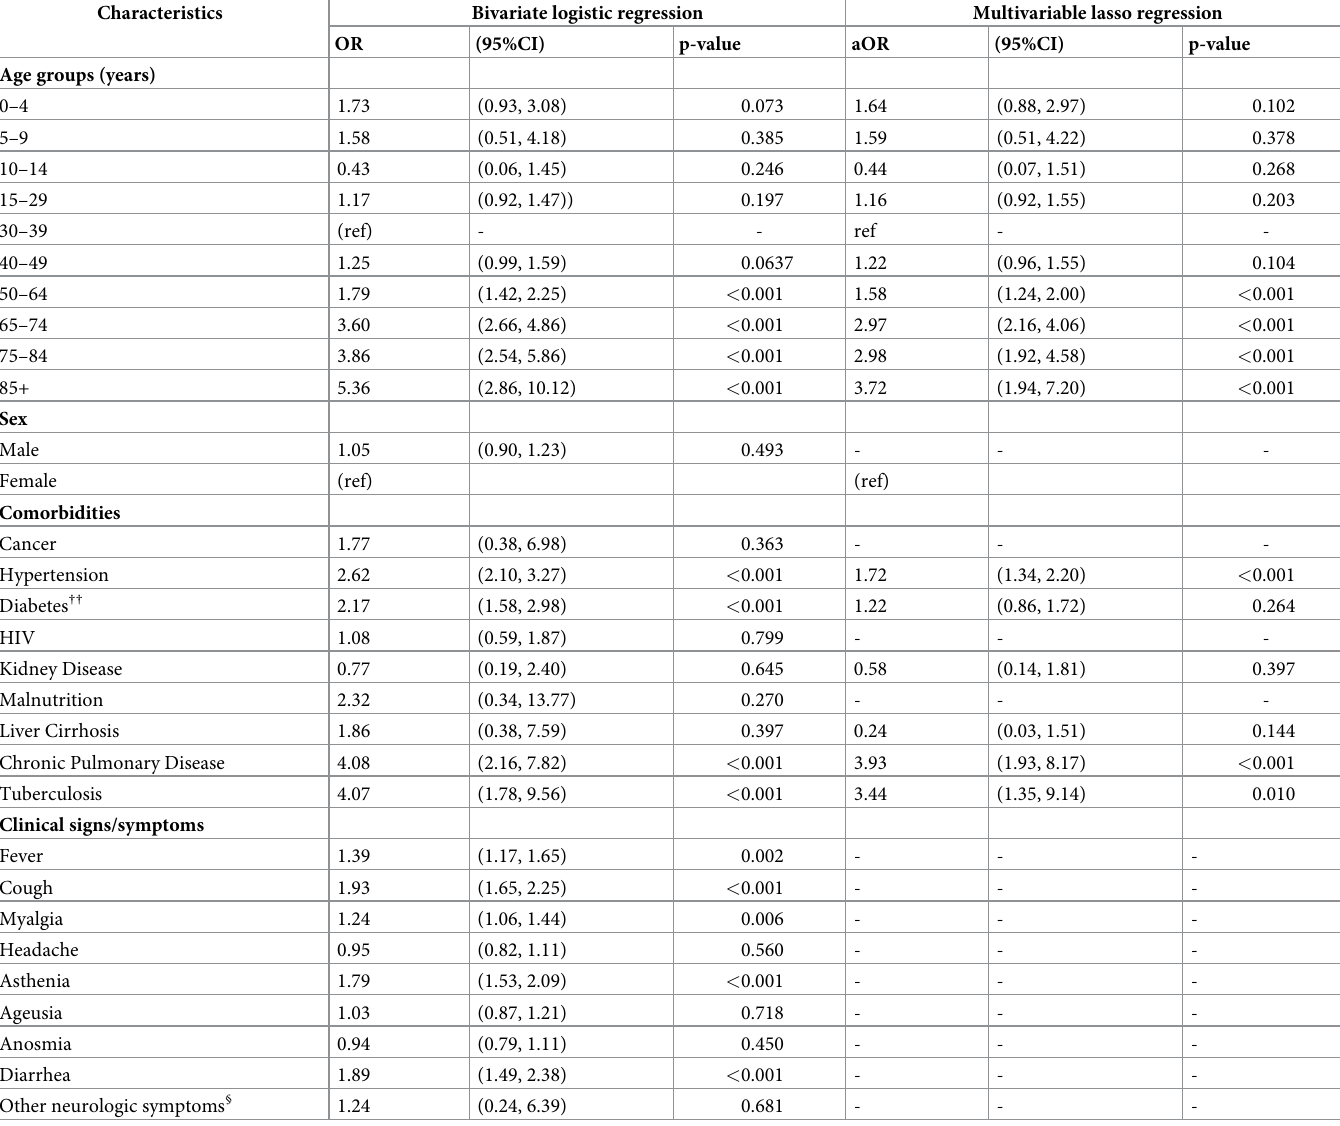
Table 3. Logistic regression modelling evaluating risk factors related to the severity of clinical manifestations of COVID-19 outpatients, i.e. comparing moderate- to-severe and mild case as the outcome.